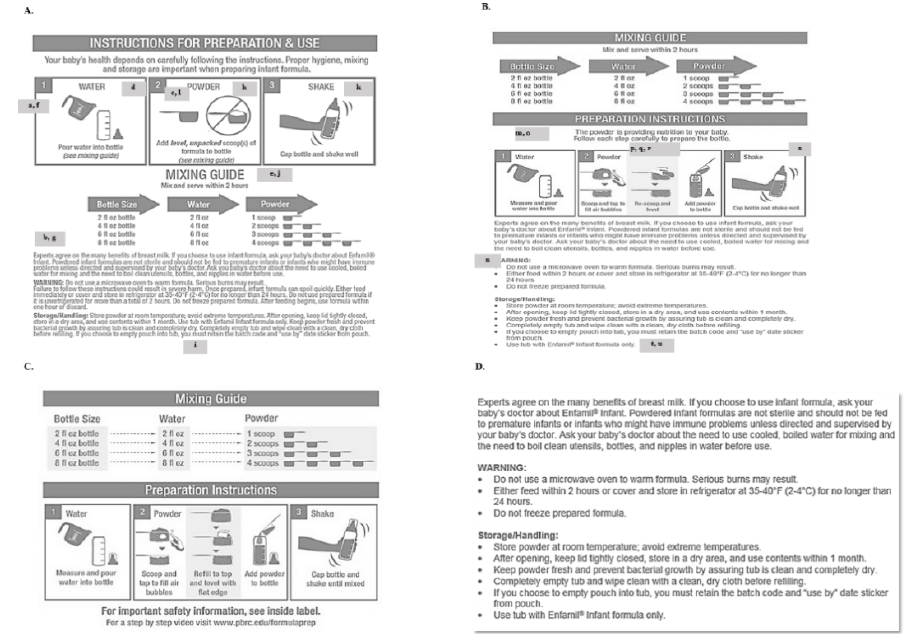
Figure 4. Modifications to Infant Formula Preparation Instructions. Panels ( A ), ( B ), ( C ) and ( D ) show modified labels per the feedback of the iterative focus groups. Panels ( C ) and ( D ) would be on the same label with panel ( D ) on the inside flap. Lower case letters indicate the primary recommendations by each focus group as summarized in Table 2.